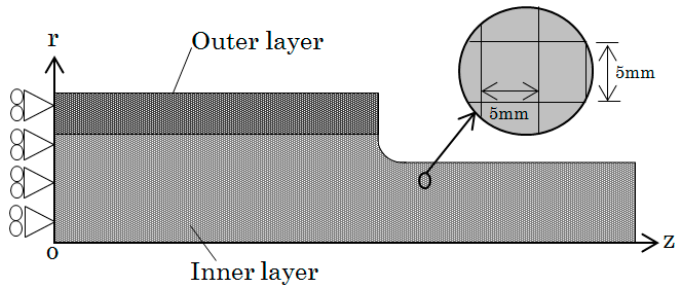
Figure 4. Analytical model and boundary condition for bimetallic roll.